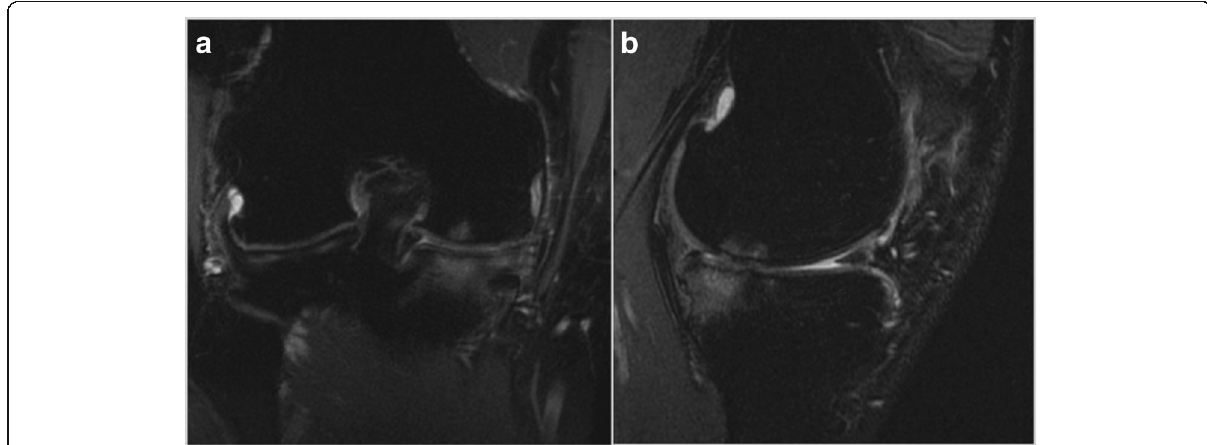
Fig. 2 A recent frontal ( a ) and sagittal ( b ) MRI Patient